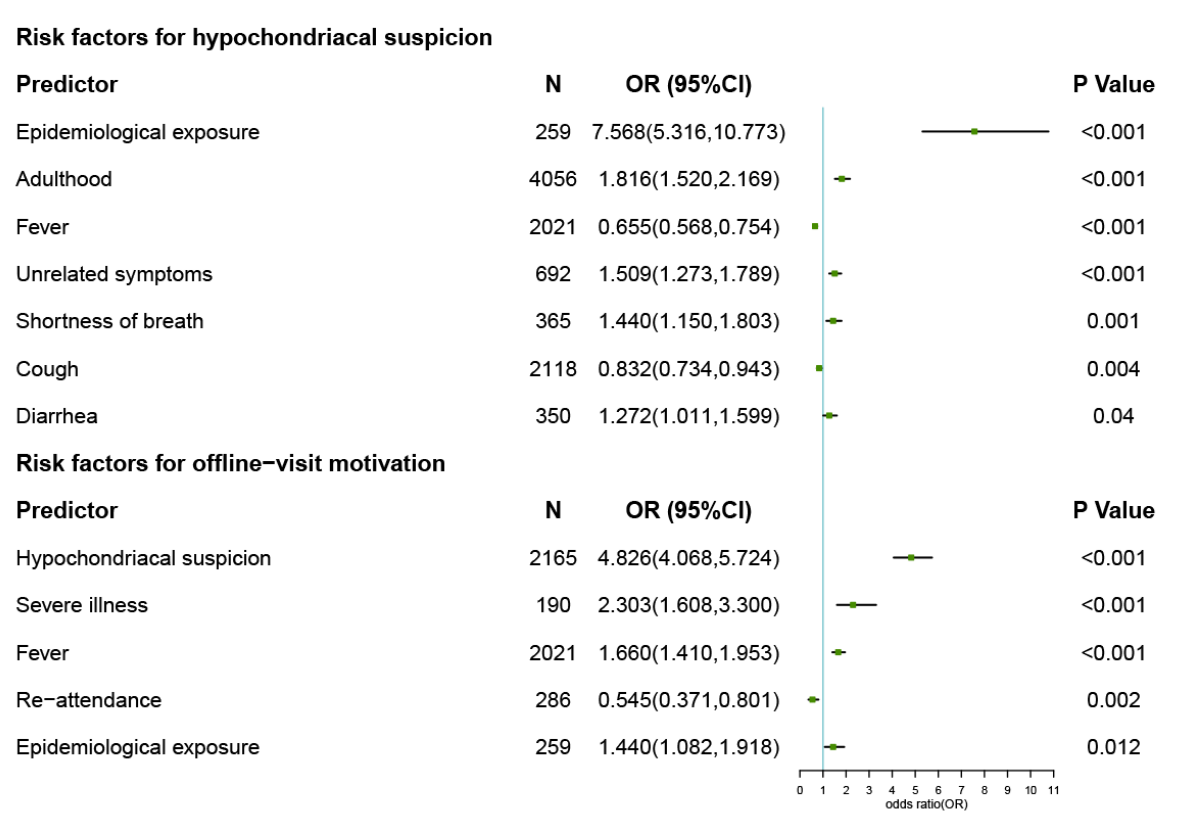
Figure 3. The independent risk factors for hypochondriacal suspicion and offline visit